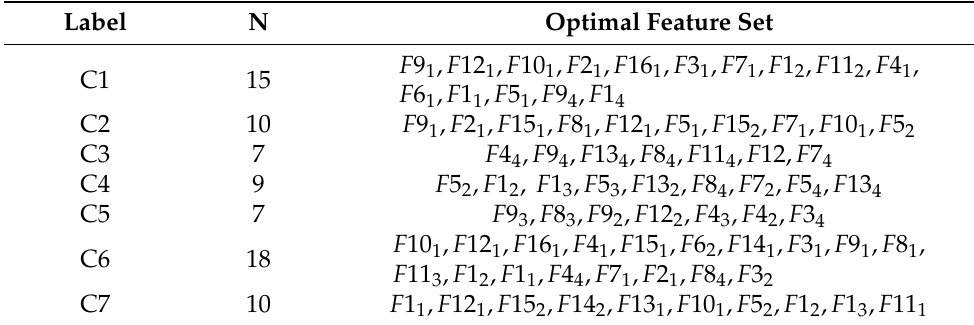
Table 2. Feature importance